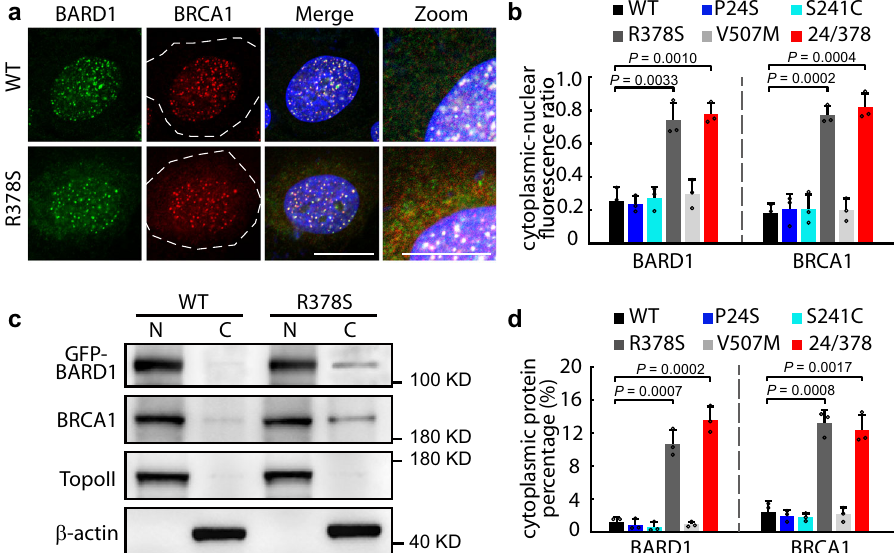
Fig. 4 Cytoplasmic translocation of BARD1 R378S . a Immuno fl uorescence of cytoplasmic BARD1 and BRCA1. Cells expressing GFP-BARD1 WT or GFP-BARD1 variants were treated with 5 Gy IR followed by immunostaining of endogenous BRCA1 4 h after IR. Whole cells are circled by dashed lines. Scale bar, 10 μ m. b Cytoplasmic-nuclear fl uorescence ratio of BARD1 and BRCA1. Fluorescence intensity of BARD1 and BRCA1 in the cytoplasm and the nucleus (note that foci were excluded from the nuclear intensity readings) were recorded. Ratios of cytoplasmic versus nuclear intensity were calculated. Five random regions in the cytoplasm and nucleus were selected from each cell. At least ten cells were included in each group. Three biologically independent replicates were performed. Data are presented as mean values ± SD. P values are calculated by unpaired two-tailed Student ’ s t tests. c Western blotting of cytoplasmic and nuclear BARD1 and BRCA1. U2OS cells expressing GFP-BARD1 WT and GFP-BARD1 variants were treated by 5 Gy IR and lysed 4 h after IR, followed by the separation of the cytoplasmic and nuclear protein fractions. The factions were respectively loaded for western blotting with anti-GFP antibody or anti-BRCA1 antibody. Type II topoisomerases (TopoII) was used as a nuclear protein loading control; β -actin was used as a cytoplasmic protein loading control. d Cytoplasmic percentage of BARD1 and BRCA1 in U2OS cells. The relative intensity of the western blot bands for BARD1 and BRCA1 were quanti fi ed, and the percentages of cytoplasmic protein/cytoplasmic + nuclear protein in different BARD1 mutant cells were calculated. Three biologically independent replicates were performed. Data are presented as mean values ± SD. P values are calculated by unpaired two- tailed Student ’ s t tests. Source data are provided as a Source Data fi